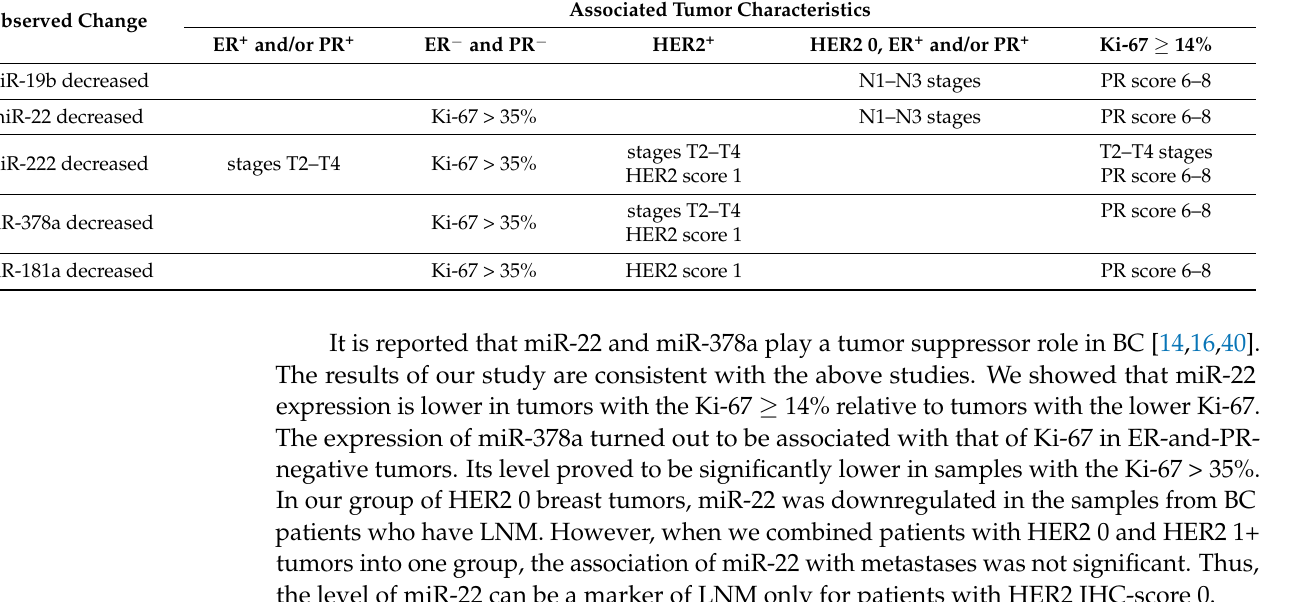
Table 8. The identified relation between differences in miRNA expression and tumor characteristics. Associated Tumor Observed Change